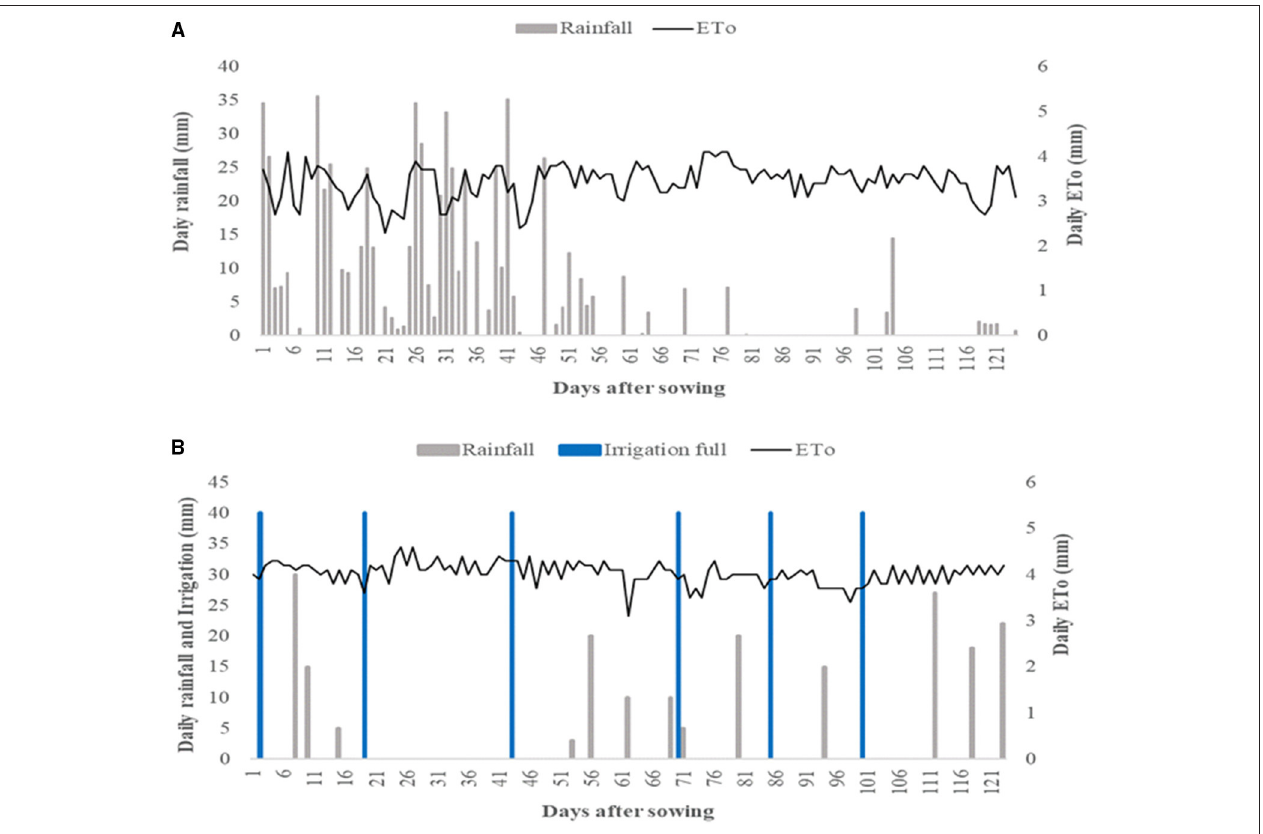
FIGURE 3 | Daily precipitation, reference evapotranspiration (ETo) and applied irrigation (100% ETc, mm) during the cropping season Feb 22–June 21, 2020 (A) and July 10–Nov 10 (B) at Barneb 2 small-scale irrigation scheme in Northeastern Ethiopia.